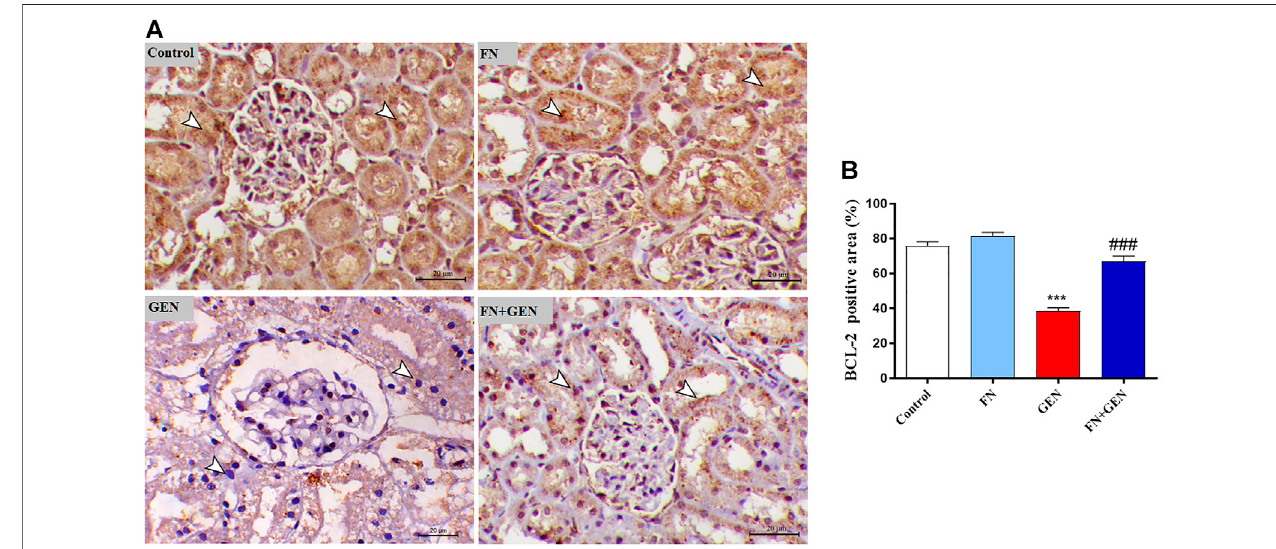
FIGURE 6 | FN upregulates renal BCL-2 in GEN-intoxicated rats. (A) Photomicrographs of renal sections from control rats and FN-treated rats demonstrating a highlevelofBCL-2expressionwithinthetubularepithelia(arrowheads),GEN-treatedratsshowinganoticeabledecreaseinBCL-2expressionwithinthetubularepithelia (arrowheads), and GEN-administered rats pre-treated with FN demonstrating a noticeable increase in BCL-2 expression within the tubular epithelia (arrowheads) (IHC, X200, scalebar=20 µm). (B) ImageanalysisofrenalBCL-2immunostainingshowingasigni fi cantdecreaseinGEN-administratedratsandasigni fi cantincreasein FN-treated rats. Results are mean ± SEM ( n = 6). ppp indicates p < 0.001 versus control group, and ### indicates p < 0.001 versus GEN group. FN: formononetin; GEN: gentamicin; and BCL-2: B-cell lymphoma 2.